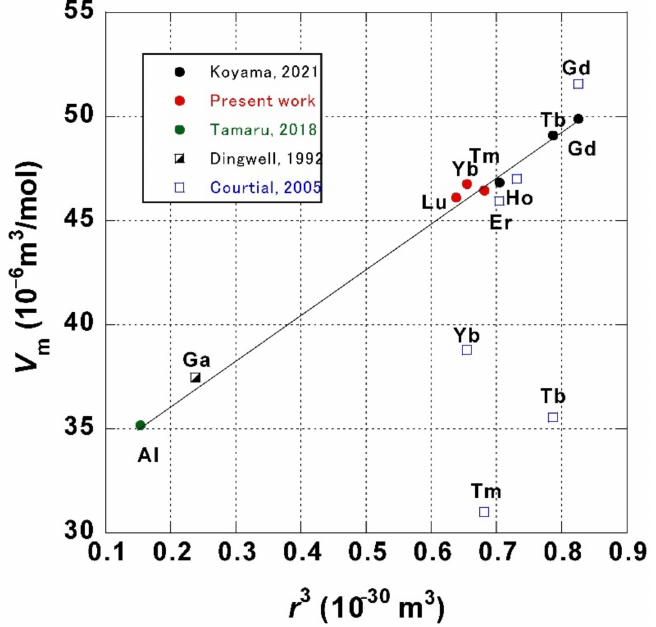
Figure 6. Molar volume of A 2 O 3 at the melting temperature and relation to the cube of the ionic